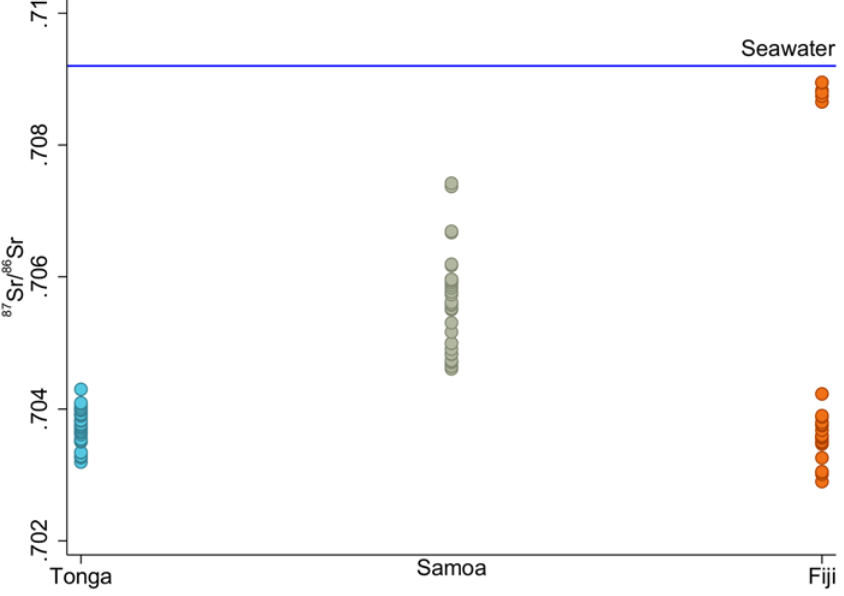
Fig 2. 87 Sr /86 Sr isotopic compositions of Tonga, Samoan, and Fijian archipelagoes. Solid line is 87 Sr / 86 Sr value of modern seawater (0.7092). Data from [87 – 90].